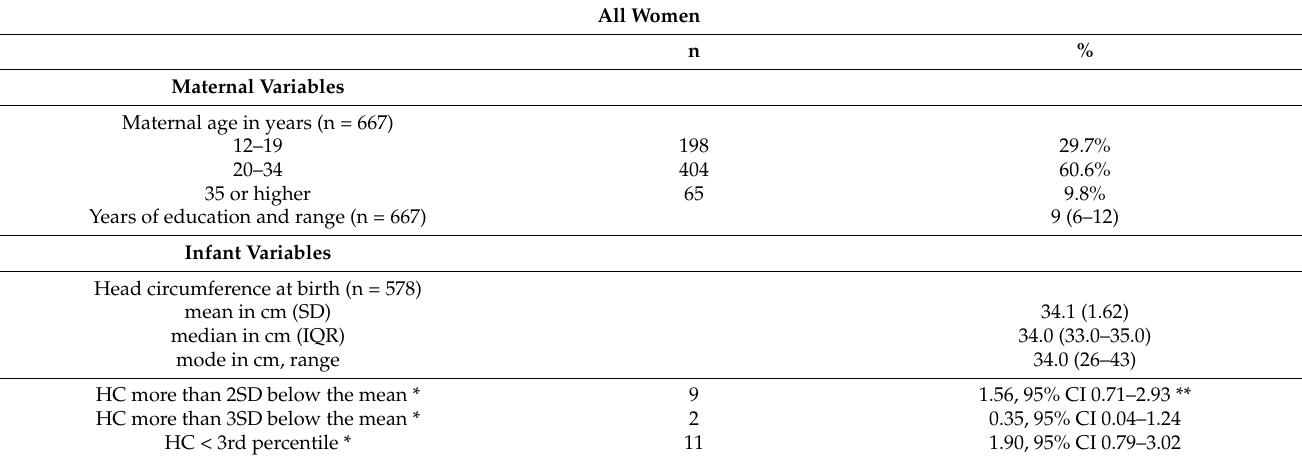
Table 1. Description of the Zika in Pregnancy in Honduras (ZIPH) cohort, 2016.